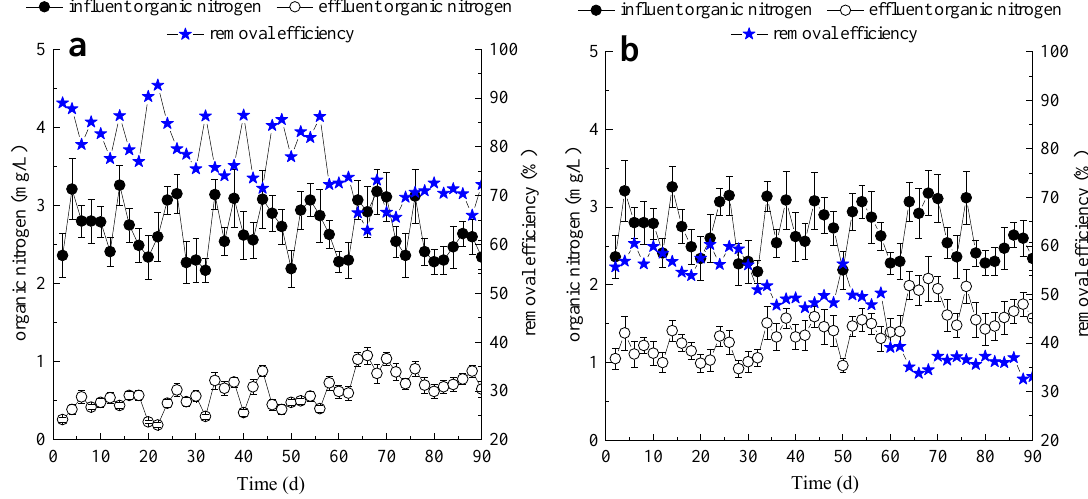
Figure 6. The removal performances of organic nitrogen in the VFCW ( a ) and HFCW ( b ) under different influent loads. The results were the averages and their standard deviations.